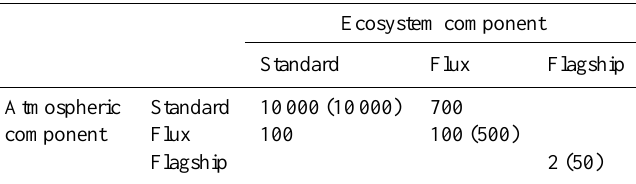
Table 1. The structure of the current and envisioned global network of measurement stations. The values indicate the approximate number of stations having different levels of atmospheric and ecosystem-specific observations in the current and envisioned (in parenthesis) mea- surement network. Besides expanding the existing network, the plan is to develop it toward a better balance between ecosystem-specific and atmospheric observations, i.e., to move toward the diagonal of the